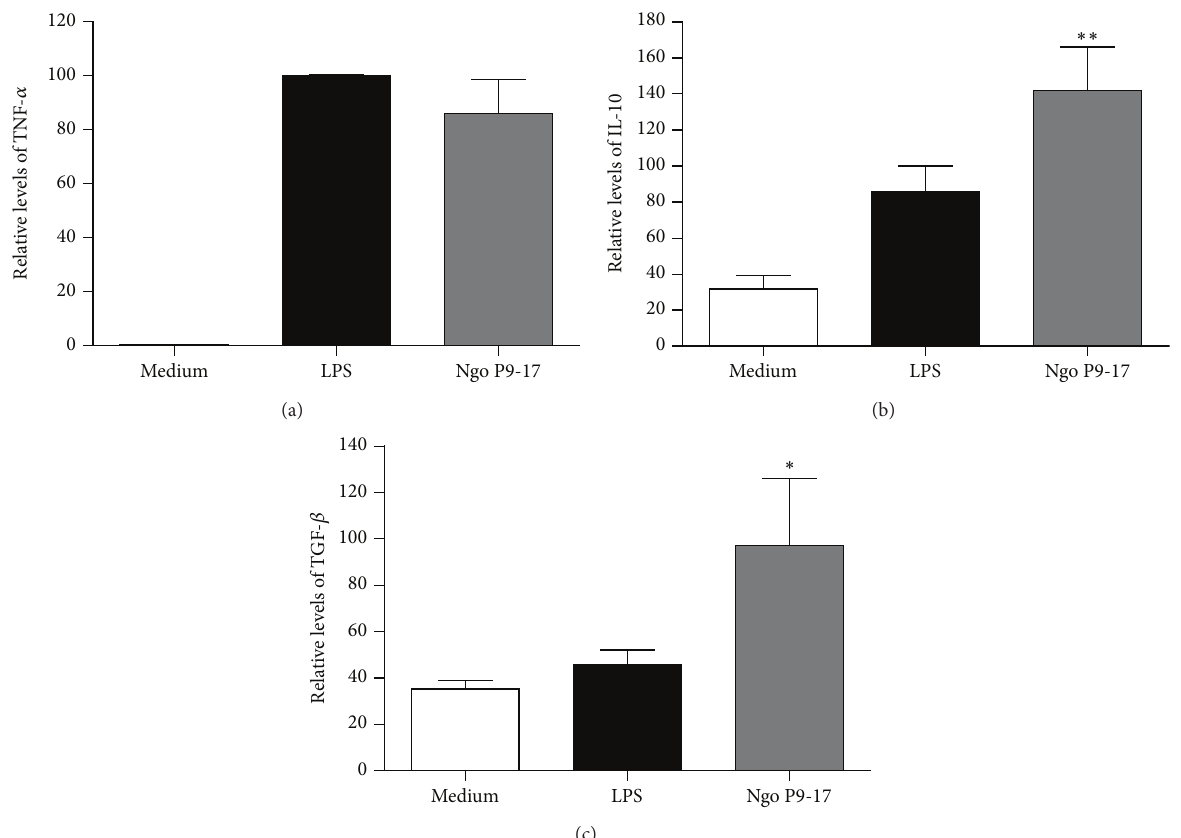
Figure 2: Cytokines induced in murine macrophage cell line infected with N. gonorrhoeae P9-17 LPS is the positive control. A statistically significant difference is found when data is compared to the level of cytokines found in the medium from cultures without infection. (a) Secretion of TNF- 𝛼 by RAW cells measured 24h after challenge. Data represent the levels of cytokine relative to levels induced by LPS. Bars are the mean ± SEM of 6 independent experiments. (b) Secretion of IL-10 after 24h treatment. 𝑛 = 5 ∗∗ indicates that P9-17 induces higher levels of IL-10 than LPS and other treatments 𝑃 < 0.01 . (c) TGF- 𝛽 1 levels on the surface of treated macrophages. Values correspond to the mean fluorescence intensity (G-mean) values relative to the levels found in untreated cells. Data are presented as the mean ± SEM of 𝑛 = 7 challenge experiments. ∗ indicates that P9-17 induces higher levels of TGF- 𝛽 1 than LPS and other treatments 𝑃 < 0.05